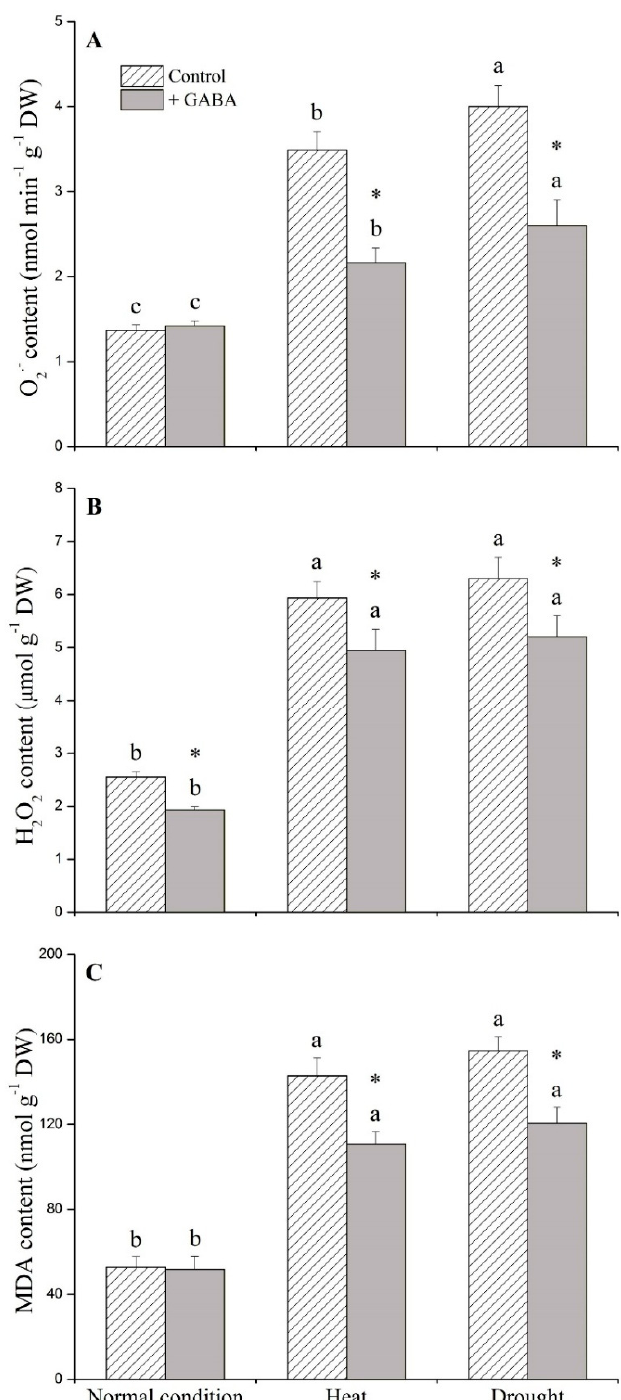
Figure 3. Effects of γ -aminobutyric acid (GABA) on ( A ) superoxide anion (O 2 − ), ( B ) hydrogen peroxide (H 2 O 2 ), and ( C ) malondialdehyde (MDA) content under normal, heat, and drought condition. Vertical bars indicate ±SE of mean ( n = 4). Different letters above columns indicate significant differences for one particular treatment (control or +GABA) under different conditions; asterisk “*” indicates significant difference between control and +GABA treatment under a given condition.